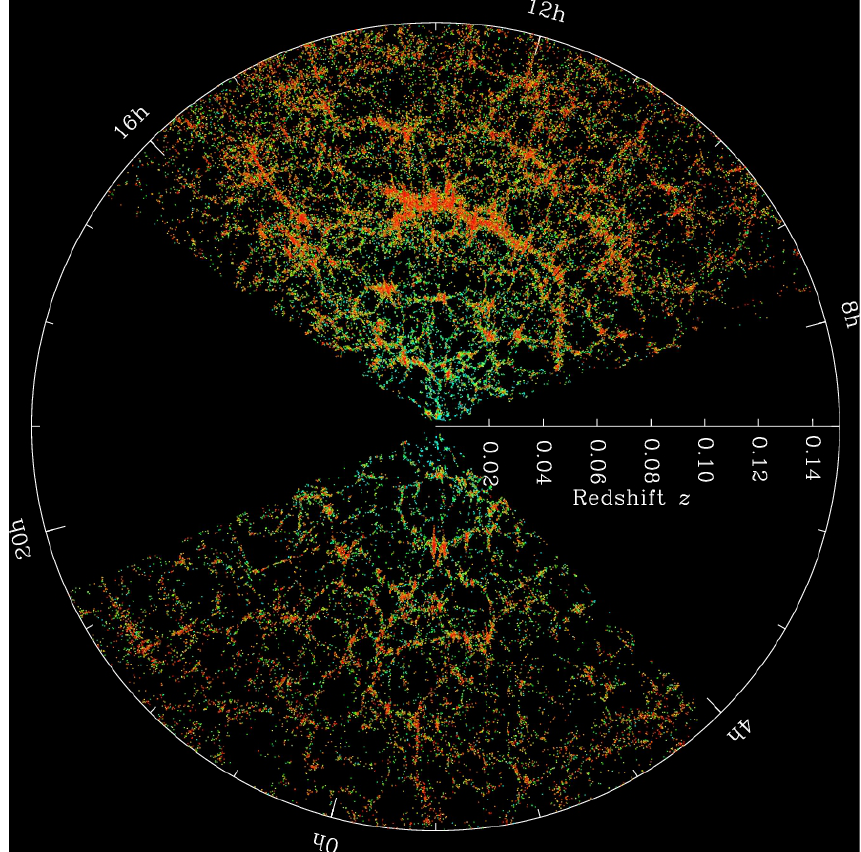
Figure 5. The Sloan Digital Sky Survey (SDSS) map of the Universe. Each dot is a galaxy; the color is the g-r color of that galaxy. Image Credit: M. Blanton and SDSS. License: Standard SDSS image